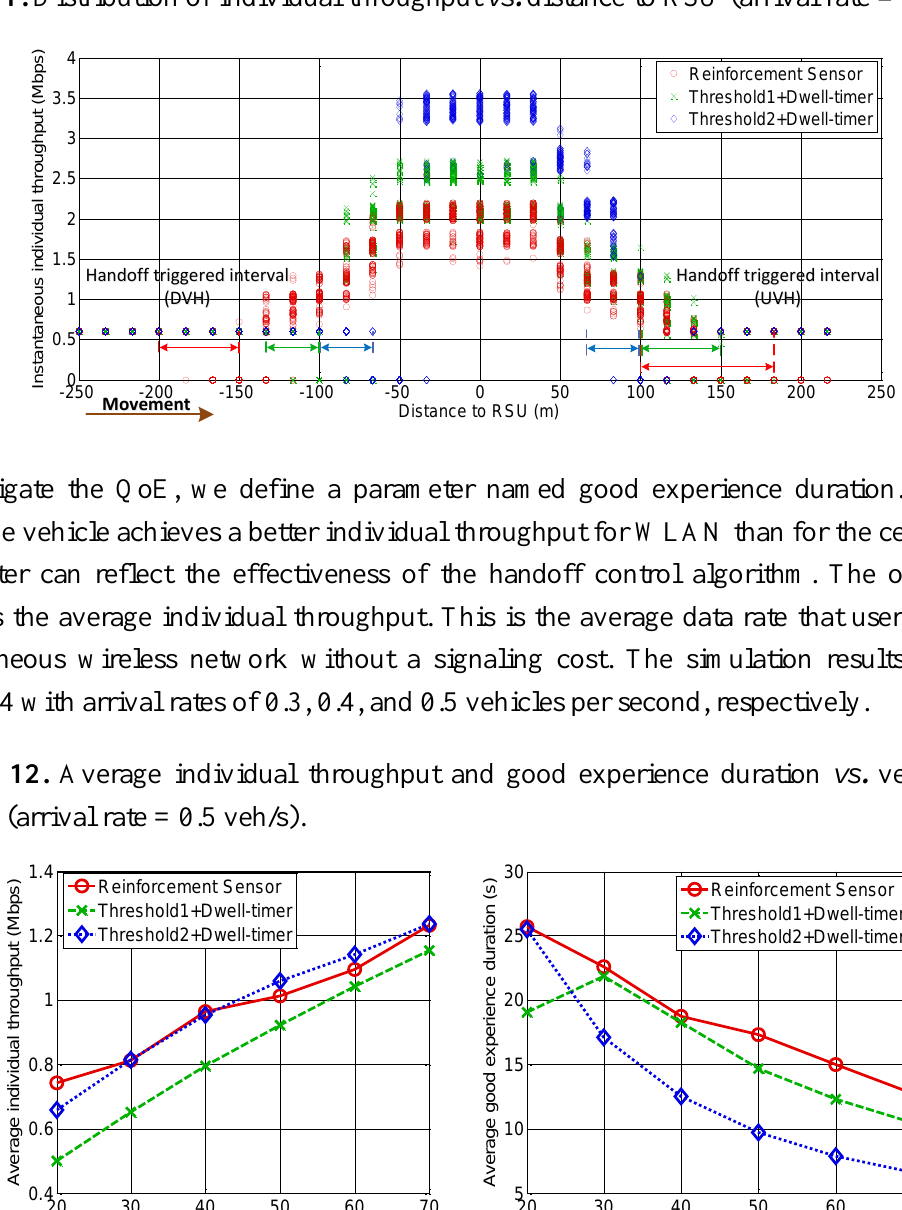
Figure 11. Distribution of individual throughput vs. distance to RSU (arrival rate = 0.3 veh/s).